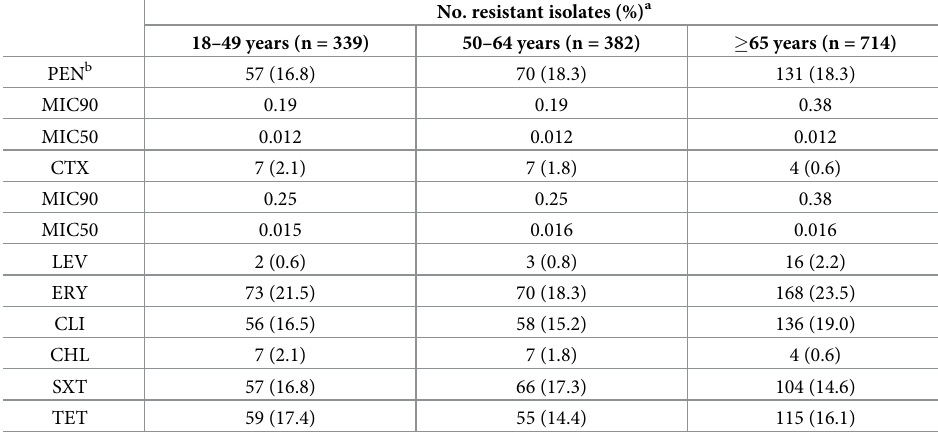
Table 3. Antimicrobial resistance of the isolates responsible for non-invasive pneumococcal pneumonia in adult patients ( � 18 years) in Portugal, 2012–2015.